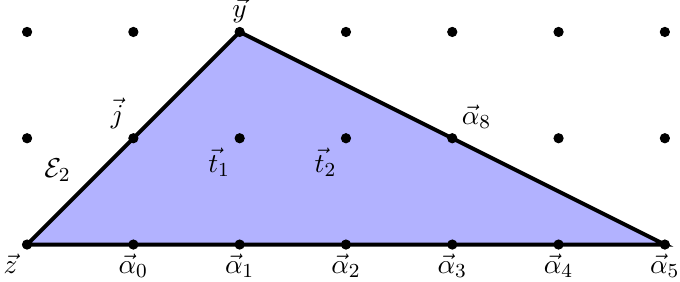
f t g and f t g 1 2